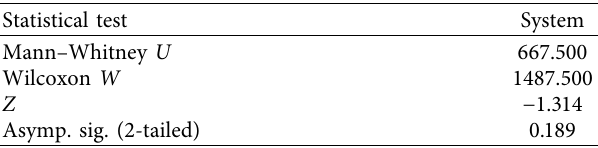
Table 9: Statistical test results.